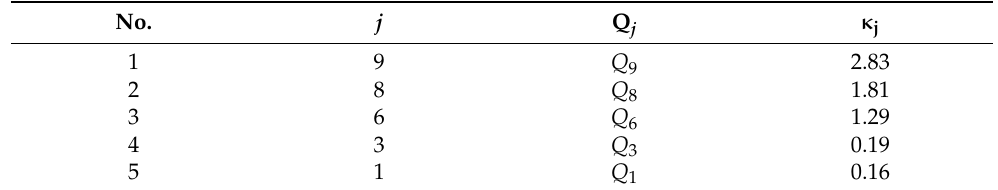
Table 12. A Ranking List of the Dominant Nodal Reactive Powers when the Index κ is Adopted as Criterion for Case 1.